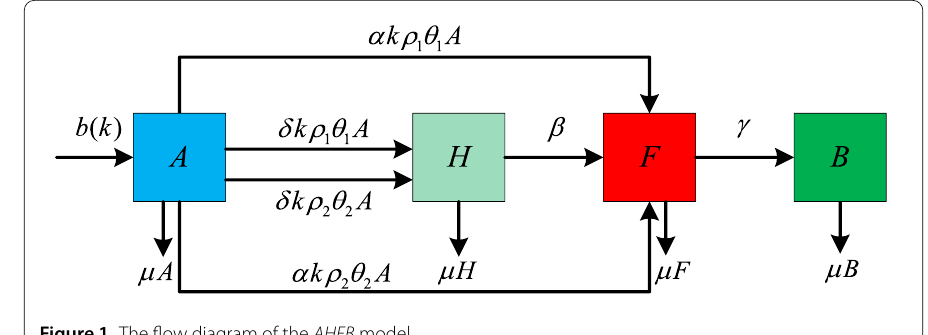
Figure 1 The flow diagram of the AHFB